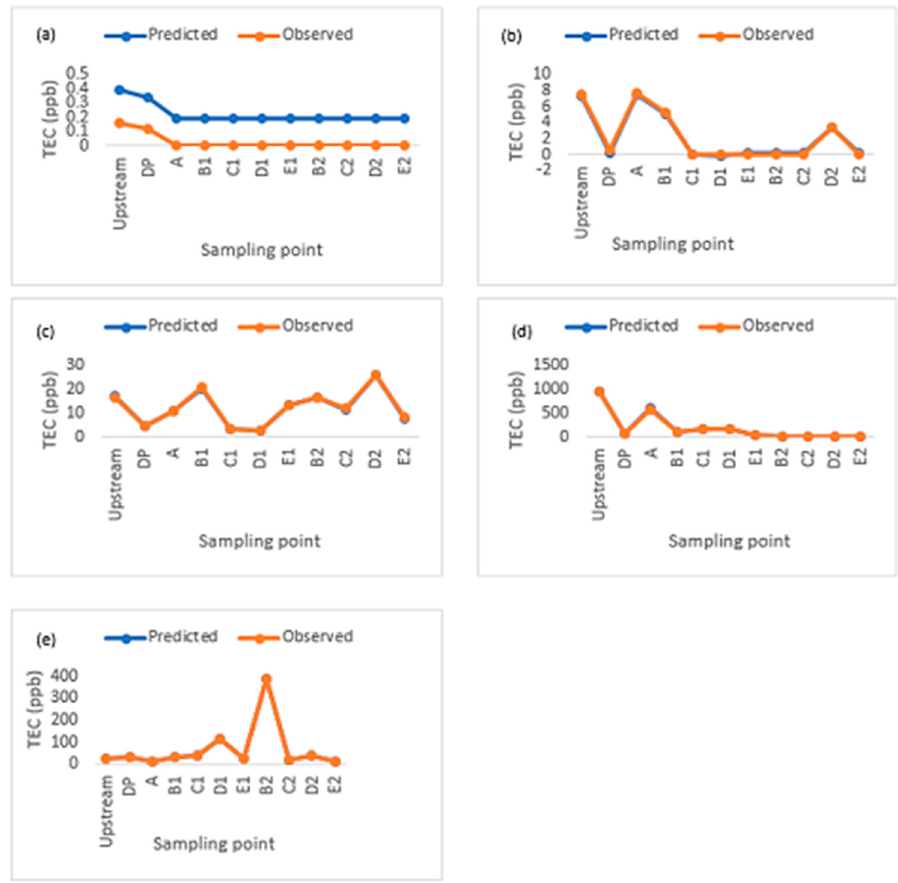
Figure 17. Monthly series of observed and predicted TEC values ( a ) May, ( b ) June, ( c ) July, ( d ) August, and ( e ) September for the training phase in the dry season.